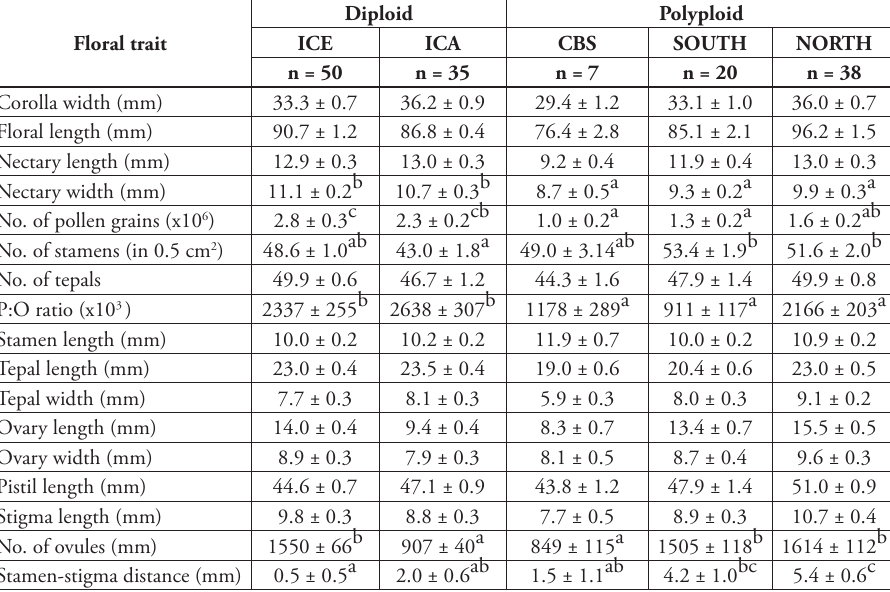
Table 2. Measurements of phenotypic floral traits, including sample size (mean ± SE) and statistical comparisons of bisexual flowers between diploid (ICE, ICA) and polyploid (CBS, SOUTH, NORTH) populations of Pachycereus pringlei in the Baja California Peninsula, Mexico. Lower case superscript letters indicate floral characters having statistically significant